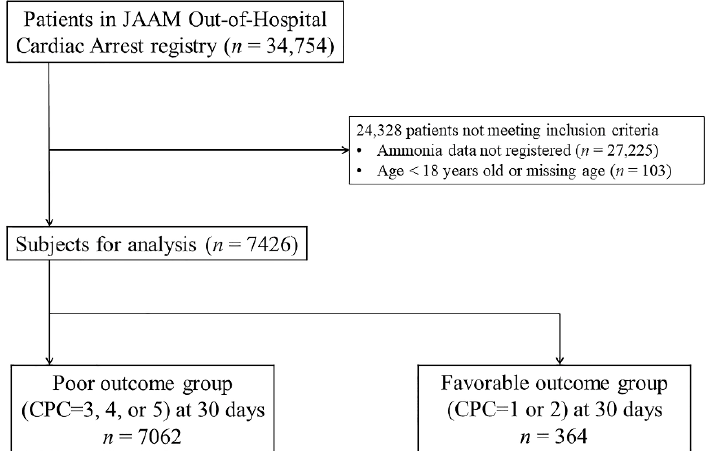
Figure 1. Flow diagram of patients analyzed. The favorable outcome group comprised patients with CPC scale scores of 1 or 2. The poor outcome group comprised patients with CPC scale sores of 3, 4, and 5. CPC: cerebral performance category, JAAM: Japanese Association for Acute Medicine. Table 1. Patient characteristics and outcomes at 30 days.